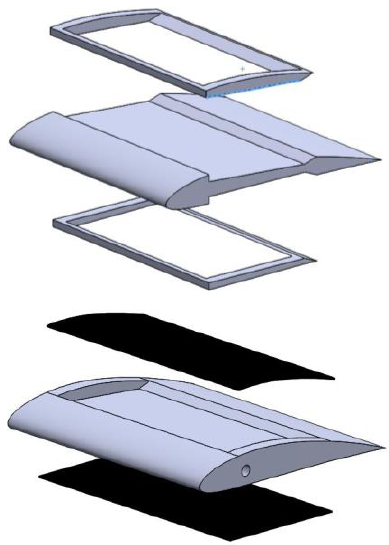
Fig . 1. The wing with flexibility on both suction and pressure surfaces .